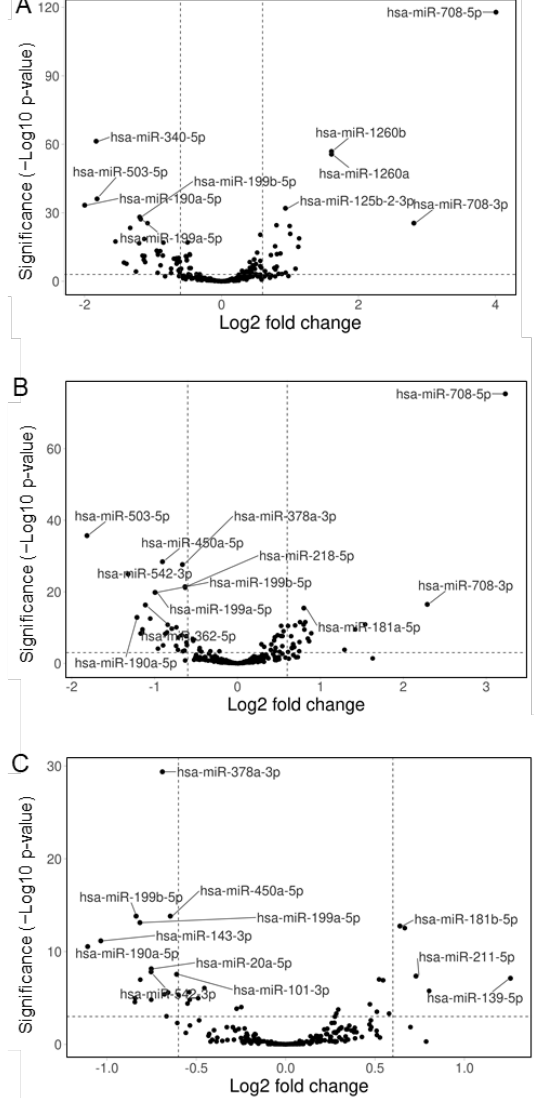
Figure 4. Volcano plots of microRNA expression changes in cultured neural cells. SH cells were treated with cannabisin B ( A ), N - trans -caffeoyltyramine ( B ), or cannabidiolic acid ( C ) for 48 h, then microRNA expression changes were detected by next-generation small RNA sequencing. Plots were prepared by the program VolcaNoseR [27]. Fields outside the vertical broken lines include miRNAs showing a fold change > 1.5; fields above the horizontal broken line contain miRNAs with a highly significant variation ( p < 0.001); hsa, homo